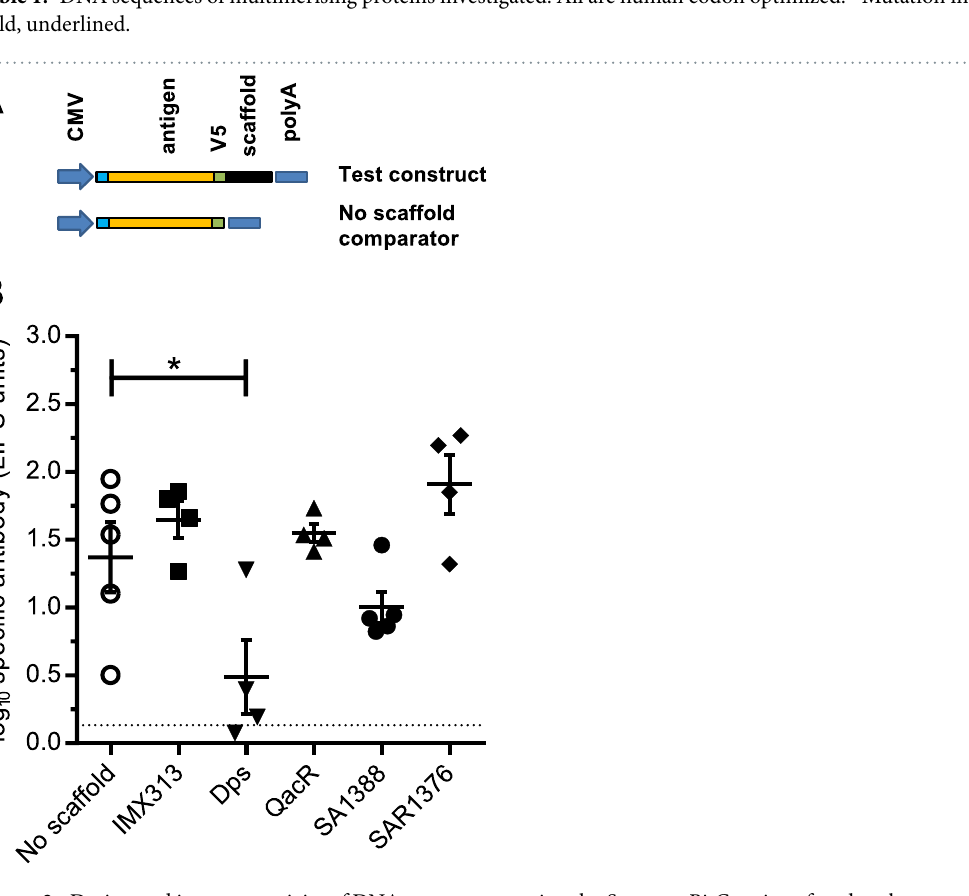
Figure 2. Design and immunogenicity of DNA vectors expressing the S . aureus BitC antigen fused to the novel multimerising scaffolds. ( A ) Design of pMono2 DNA vaccination vectors constructs. CMV: CMV IE94 promoter, TPA: human tissue plasminogen activator signal sequence, antigen: antigen being tested, V5: epitope tag and linker sequence, scaffold: multimerising domain, BGH pA: Bovine growth hormone polyadenylation sequence. ( B ) BitC-specific IgG response after two immunisations of groups of 4 or 5 BALB/c mice with 50 µ g BitC-scaffold DNA two weeks apart, measured by LIPS assay at 3 weeks post boost. Each symbol represents a single mouse. Dotted line: threshold for background response, * p <